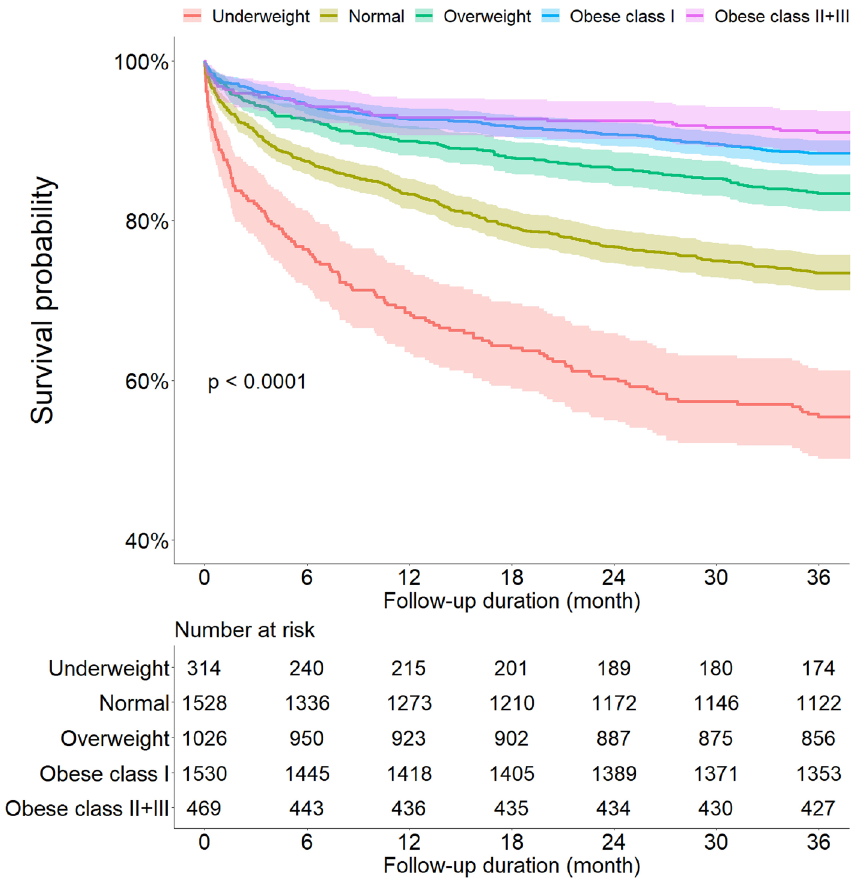
Figure 2. All-cause death free survival rates according to BMI level analysis by Kaplan–Meier plot with 95% confidence intervals. BMI, body mass index.